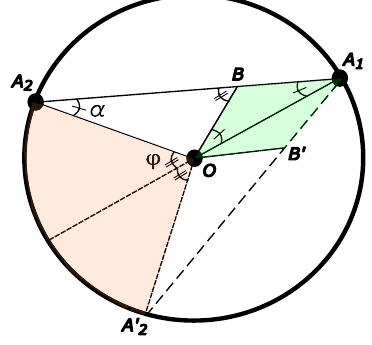
Fig. 1 Thepaintedoverregionisthepermissiblelocationofthesecond randomly generated point A 2 with respect to the first one A 1 where the high degree of alignment is observed for the three points. The central point O in an origin is